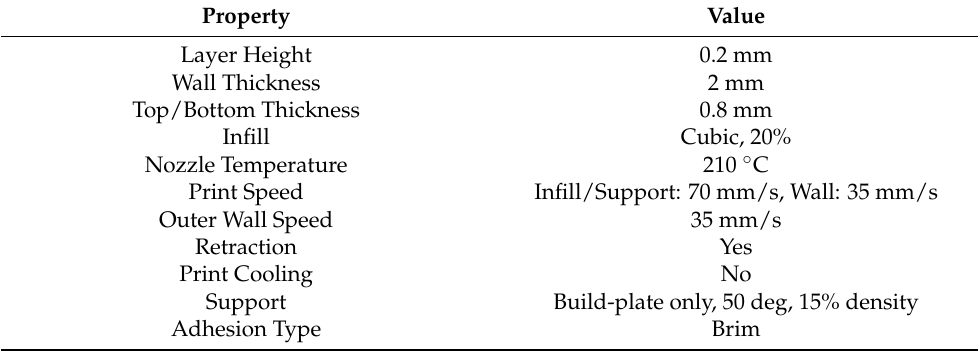
Table 1. Print Settings for PLA.